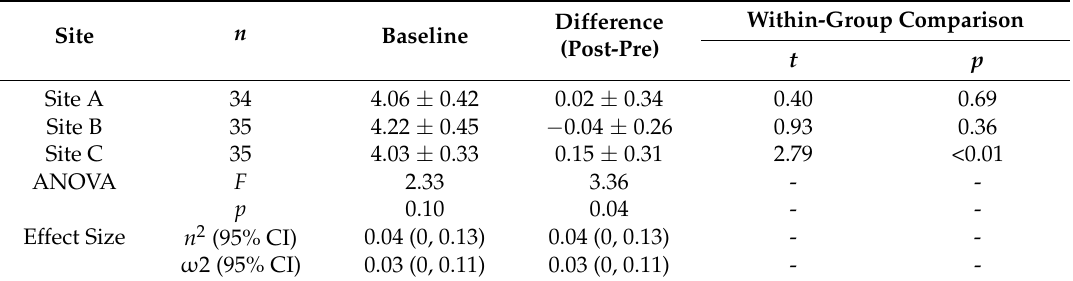
Table 3. Pre- and post-visit comparison of levels of amylase across the three sites ( n = 104). Site n